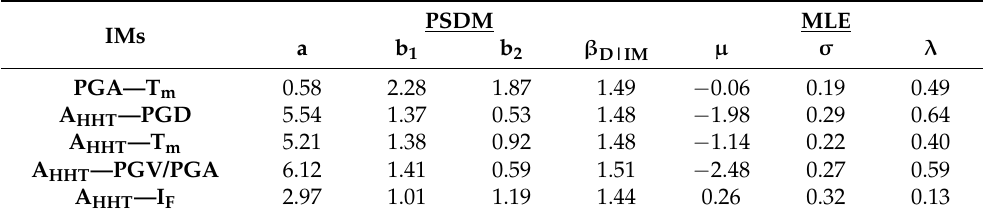
Table 3. Proposed bivariate fragility surface parameters.